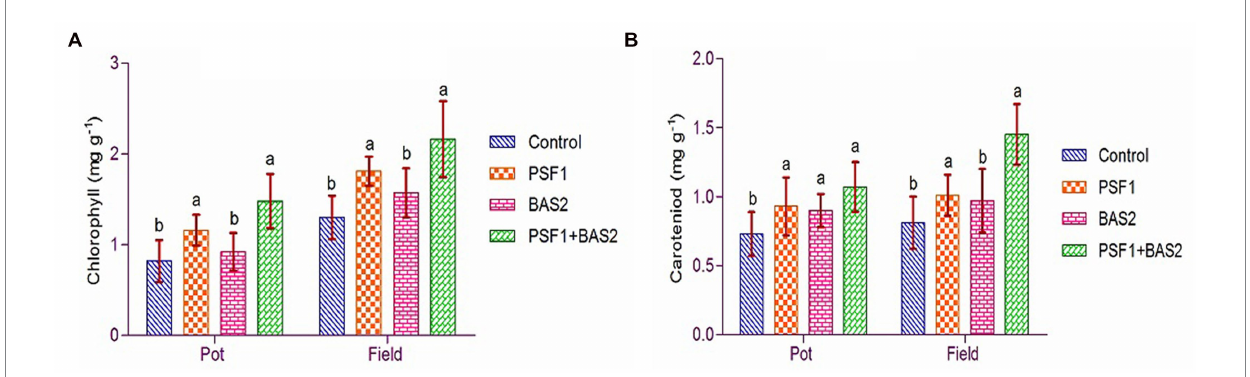
FIGURE 5 Effect of PGPR biostimulants Pseudomonas fluorescens (PSF1) and Bacillus subtilis (BAS2) on photosynthetic pigments (A) chlorophyll; and (B) carotenoid under pot and field conditions. Error bar represents the standard deviation ( n = 3). Small alphabetical letters above the error bar indicate significant difference between treatments according to Tukey’s post-hoc test ( p ≤ 0.05).